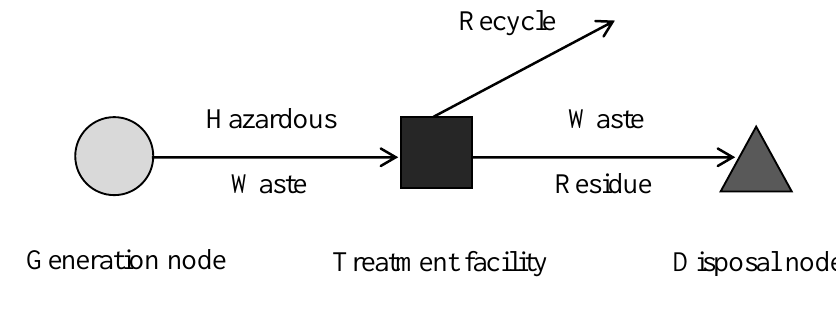
Fig 2 . Process of treatment and disposal of